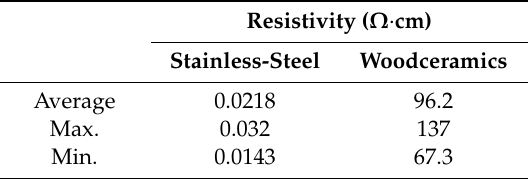
Table 2. Resistivities of woodceramics and stainless-steel.